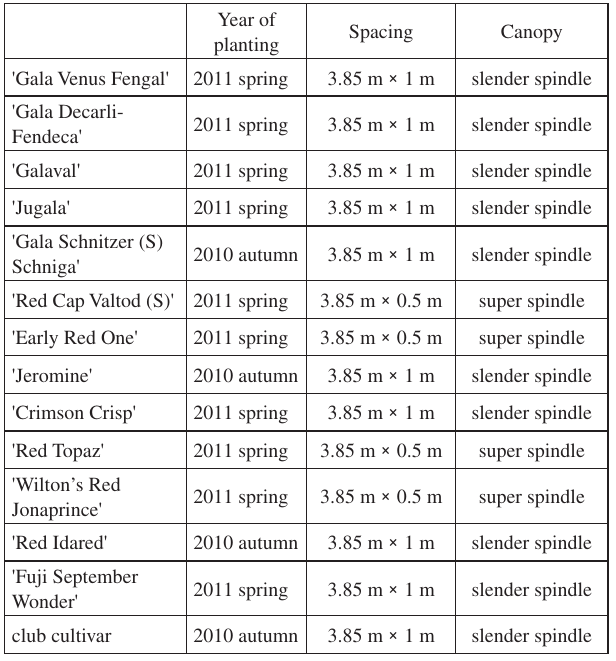
Table 1: The planting design of the 14 evaluated